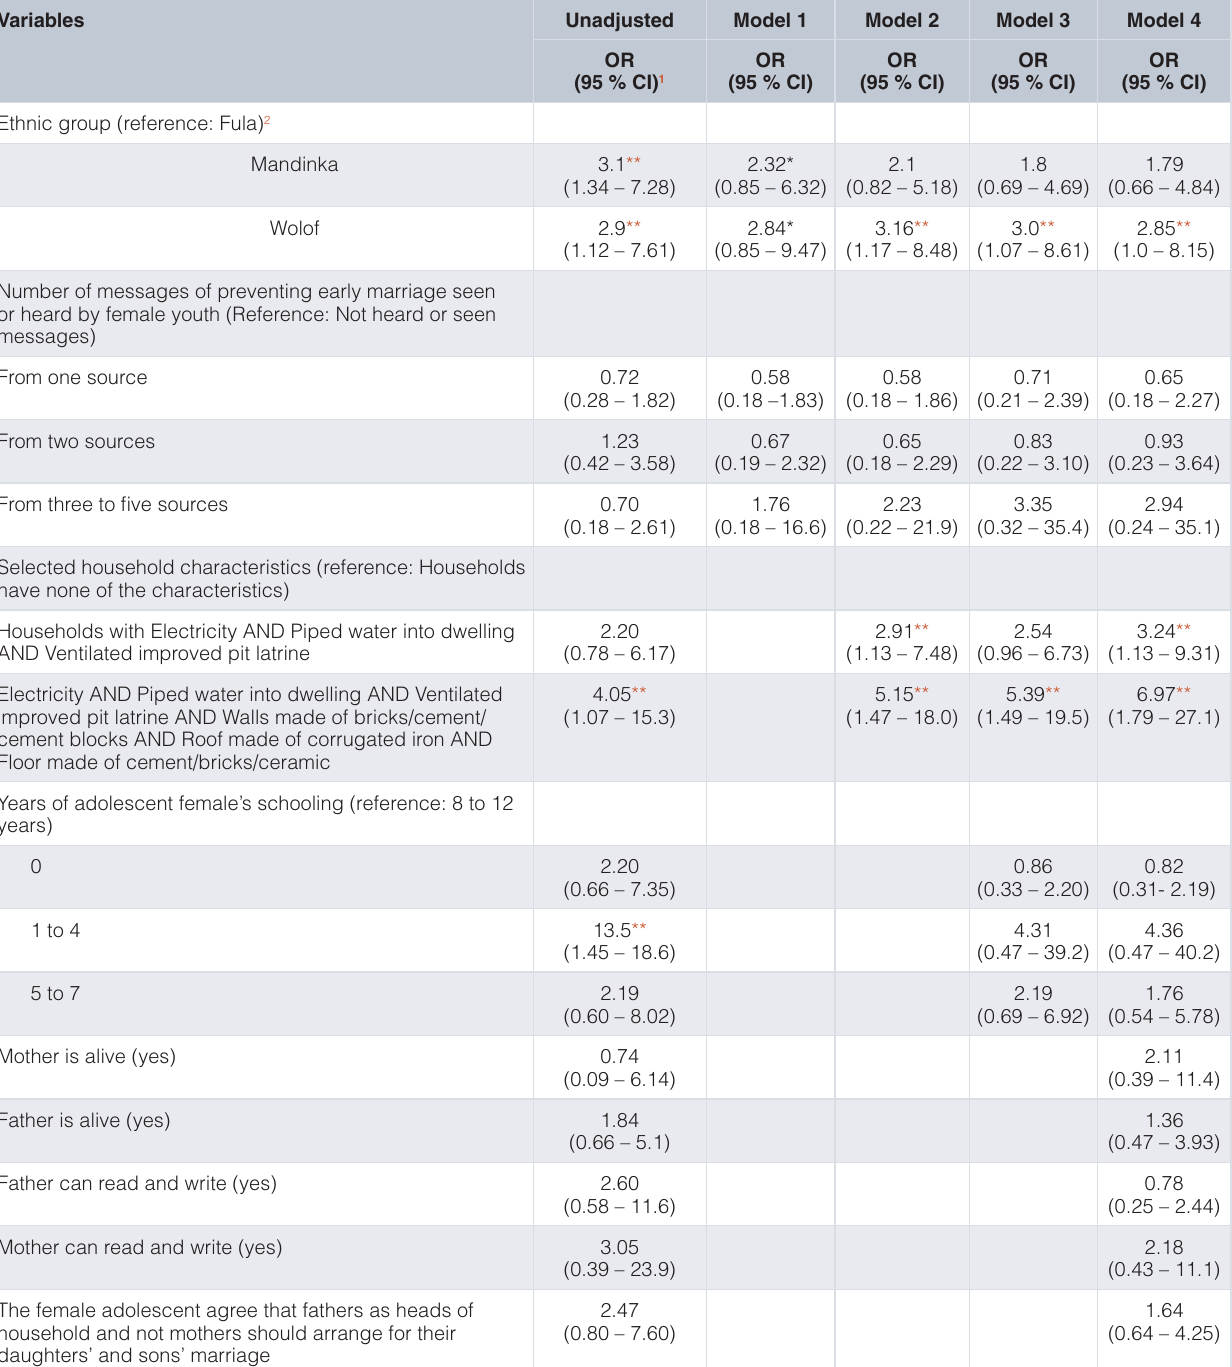
Table 4. Regression analysis results for factors associated with marrying before 18